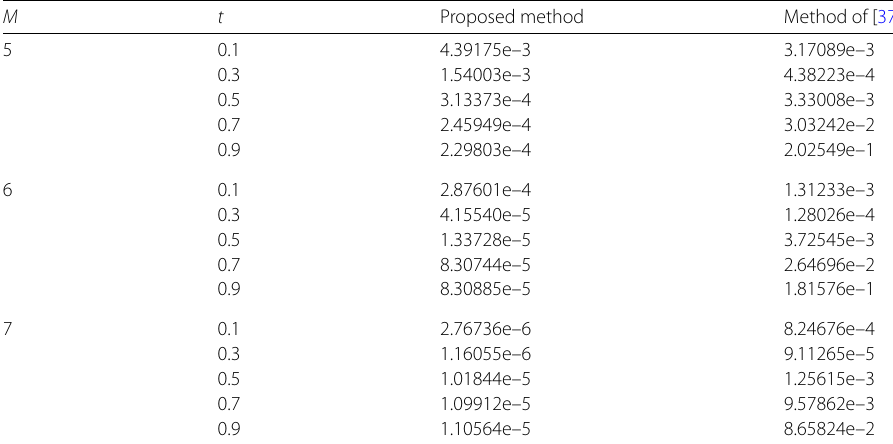
Table 2 Comparison of the AEs for Example 5.2 with υ ( t ) = t